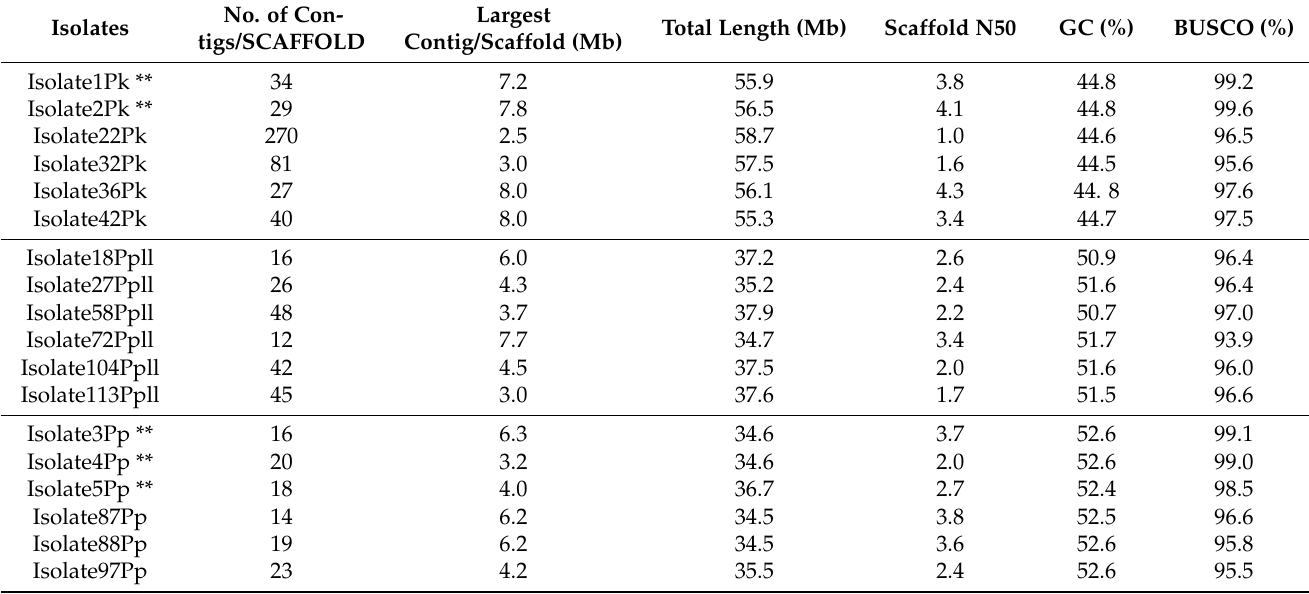
Table 1. Genome assembly statistics of AB isolates. Isolates with double asterisks have illumina reads retrieved from NCBI; as such, hybrid assembly was carried out for